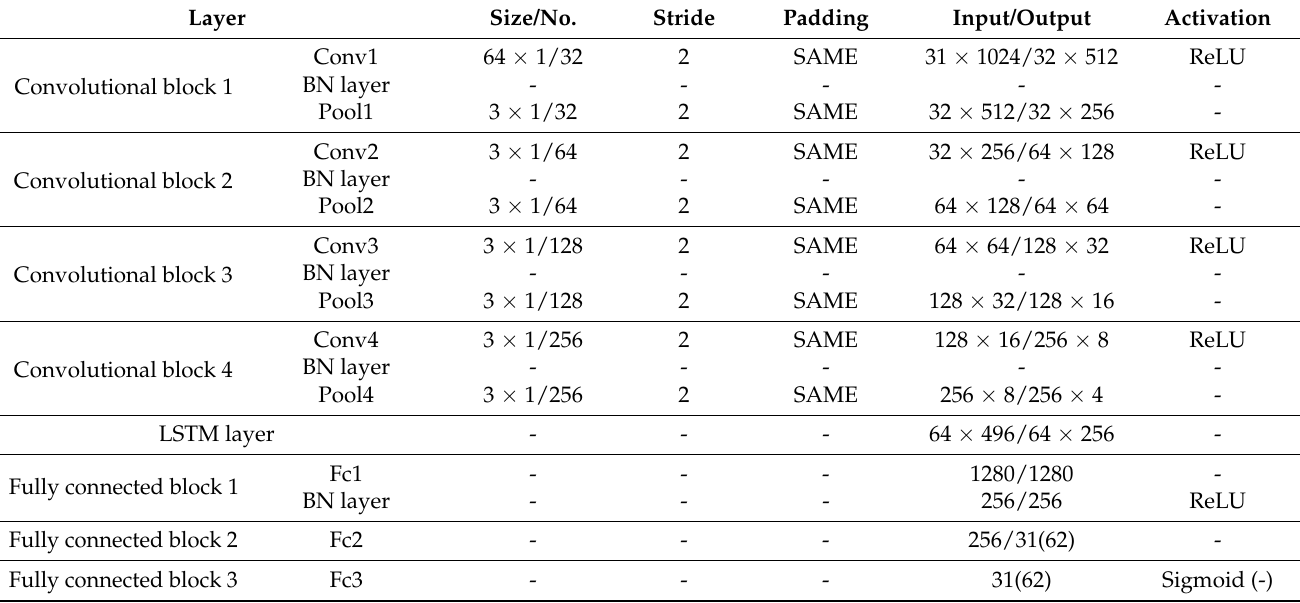
Figure 8. It should be noted that the accuracy is the ratio of the number of samples correctly localized in the validation set. Val-Mse is the mean square error between the prediction vector of the damage severity and the target vector. Table 2. Parameters of CNN-LSTM. 10.2 software.